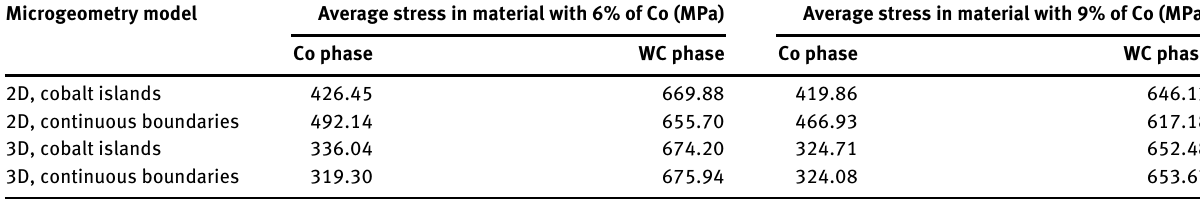
Table 2: Stress averages computed with respect to the cobalt content, dimensionality and microgeometry type.